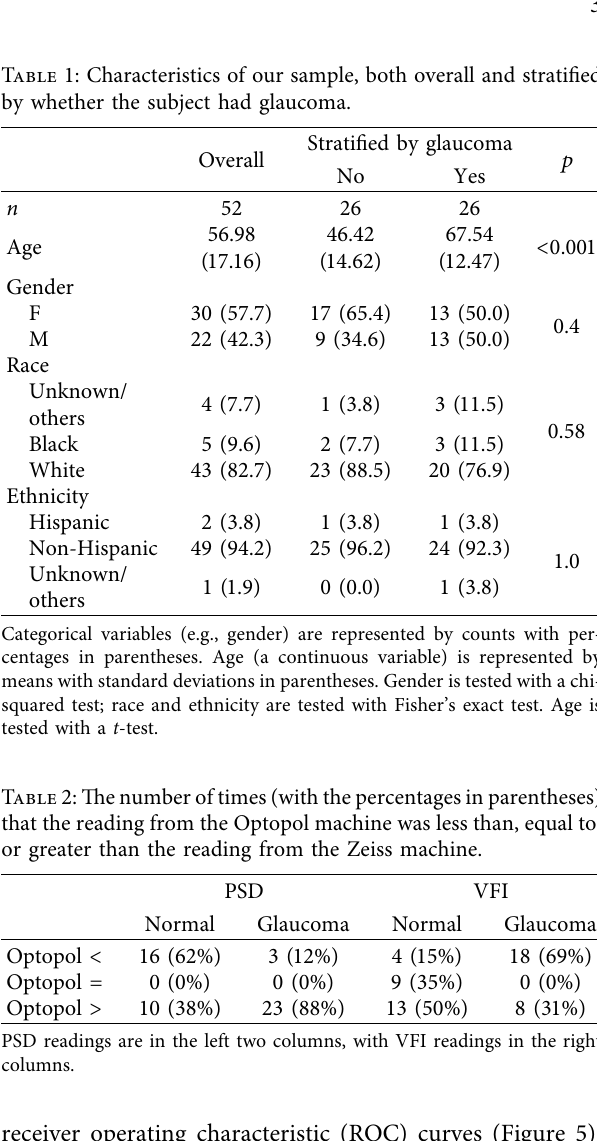
PSD readings are in the left two columns, with VFI readings in the right